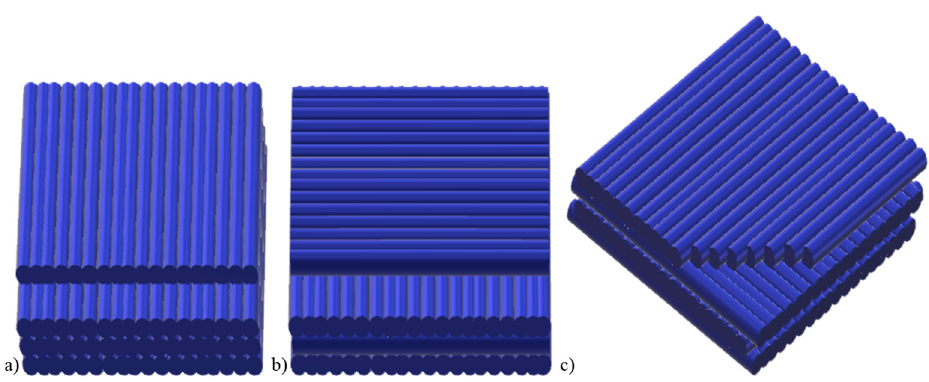
Figure 2. Print orientation: ( a ) edge (Y), ( b ) horizontal (X), ( c ) vertical (Z). Own elaboration based on [19].